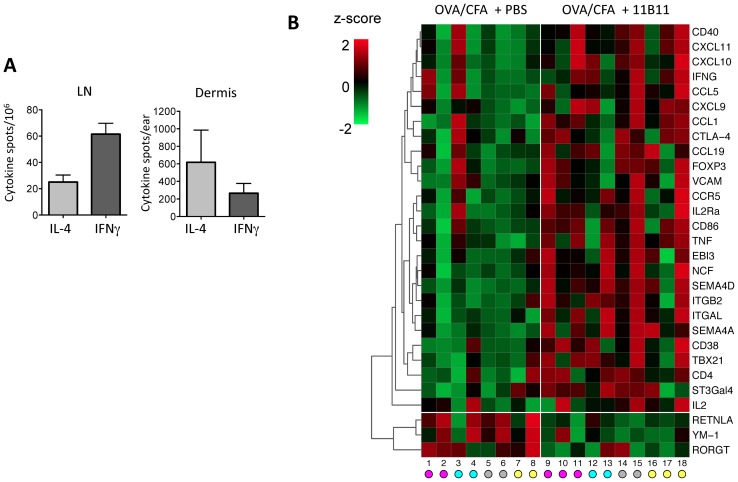
Short-term IL-4 blockade modulates the inflamed tissue environment.
A) Antigen-specific IL-4 and IFNγ production by ELISPOT, day 7 following OVA/CFA immunization. B) Heat map of TLDA array genes (n = 94 genes examined, Table S1) expressed in the ear dermis of control and anti-IL-4 treated OVA/CFA immunized mice. Anti-IL-4 treatment (or PBS) was administered on day 7 and 10 post-immunization and RNA extracted on day 14. 29 genes (rows) were identified based on the treatment p-value (<0.05) after a 2-way ANOVA. The columns correspond to 18 samples. The colored circles beneath the heat map indicate which of the four experiments the sample was processed in. Color in the heat map corresponds to the z-score of relative expression data. For each gene, the z-score was computed separately in each of the four experiments rather than using all 18 samples together. Genes were clustered using correlation and average linkage.